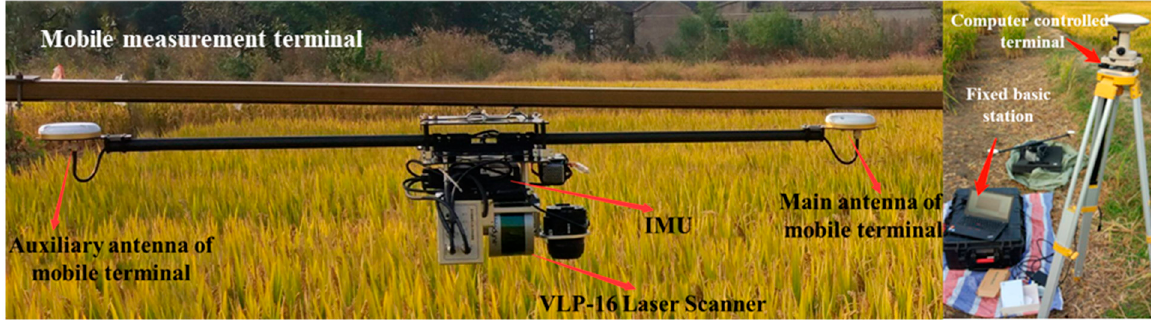
Figure 1. LiDAR measuring system. Table 1. Parameters of the VLP-16 laser scanner.